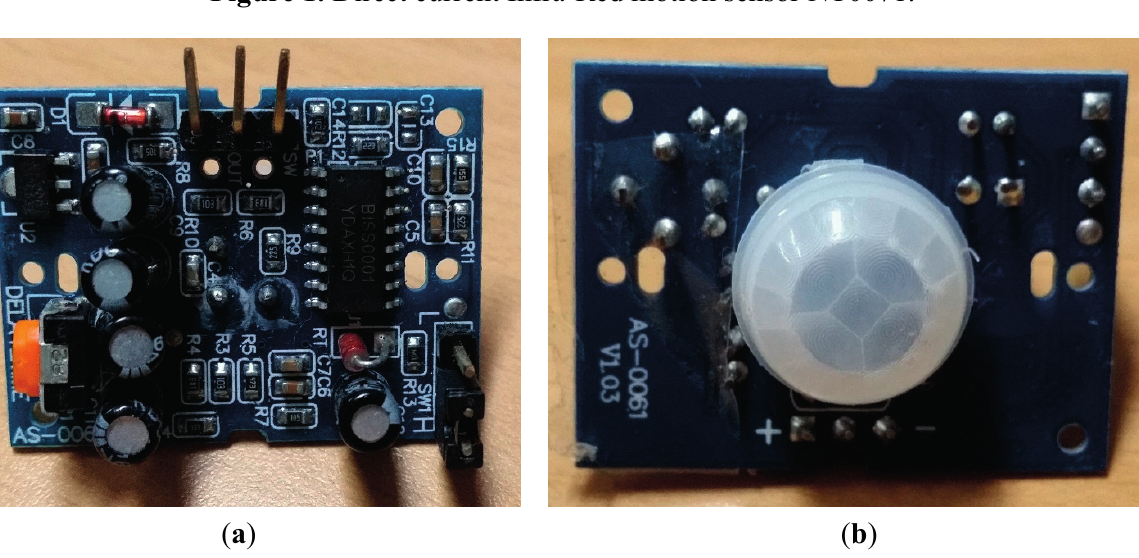
Figure 1. Direct current Infra-Red motion sensor NT0071.